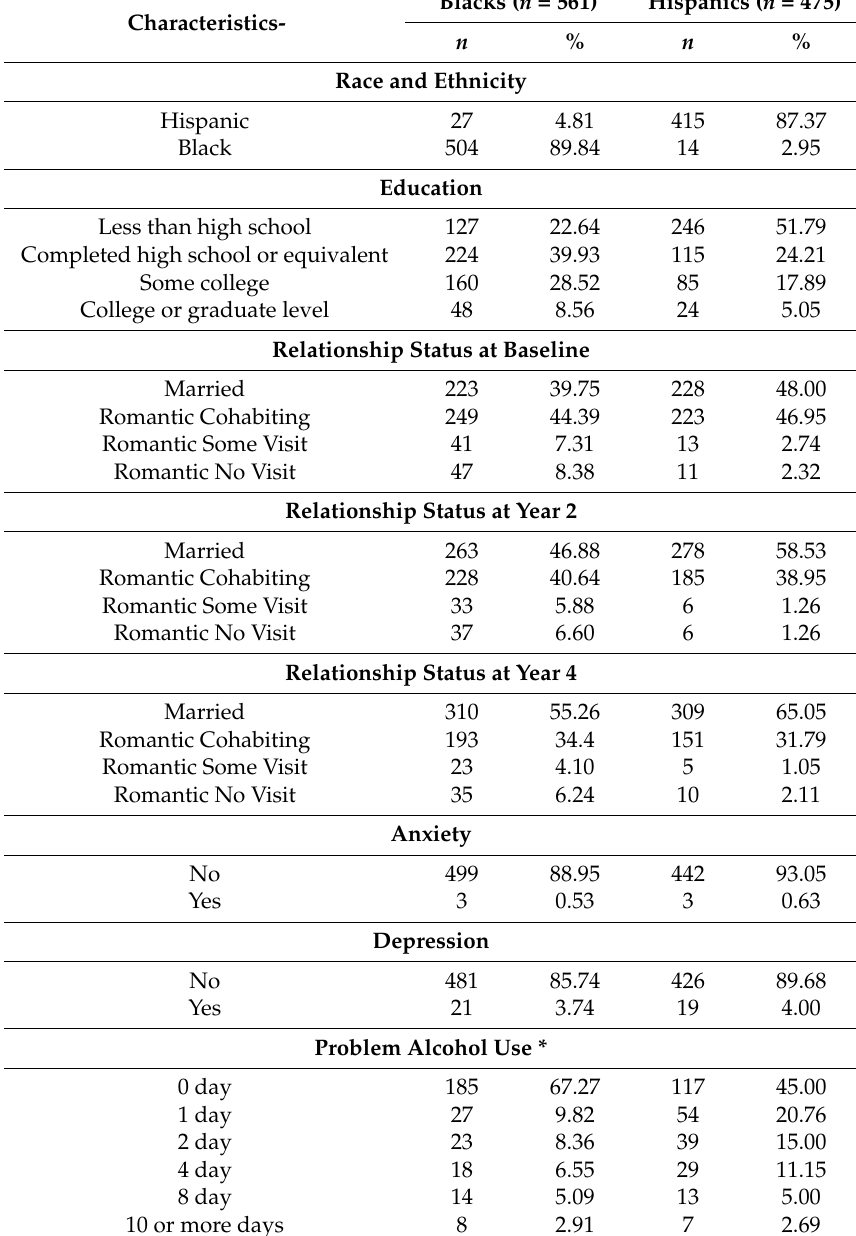
Table 1. Descriptive characteristics of male partners’ socio-demographics and mental health.